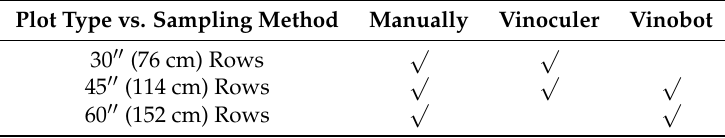
Figure 5. Field configuration at the MU Bradford Research Center. Small vertical boxes represent 10 plants, with sorghum marked by blue and corn marked by red boxes. Full boxes indicated plants selected for destructive sampling. Table 5. Sampling method performed per indicated type of